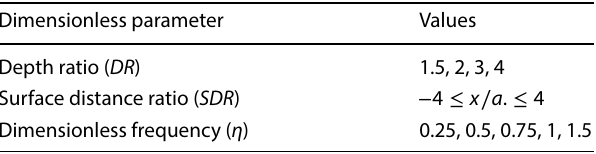
Fig. 1 Schematic representation of the soil-cavity model and refer- ence point located on the ground surface to the parametric study Table 1 Assigned values to the dimensionless parameters in the parametric study Dimensionless